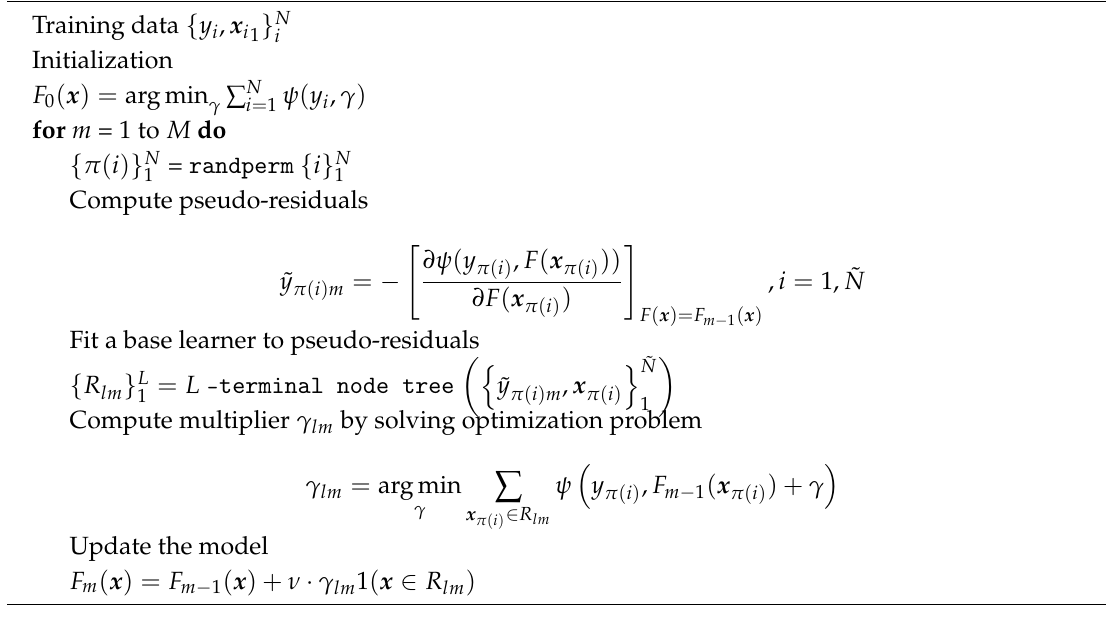
Algorithm 1 Stochastic Gradient Boosting algorithm.